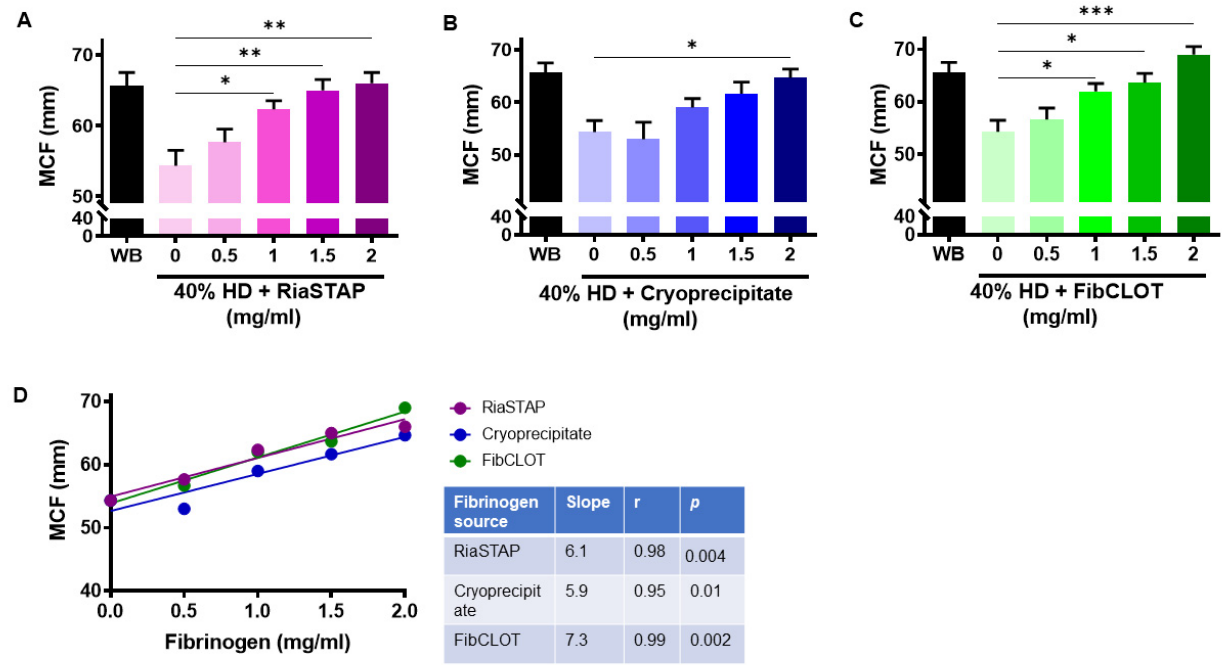
Figure 5. Clot strength is directly proportional to the concentration of fibrinogen supplementation. Thromboelastography was performed on whole blood (WB) or 40% hemodiluted clots (HD) ± ( A ) RiaSTAP ® , ( B ) cryoprecipitate or ( C ) FibCLOT ® (0.5–2 mg/mL) using EXTEM reagent and analyzed using ROTEM thromboelastography. Data represent mean data ± SEM of maximum clot firmness (MCF). ( D ) Correlation of MCF with fibrinogen concentration. n = 3, * p < 0.05, ** p < 0.01, *** p < 0.001 vs. 0.5 mg/mL.